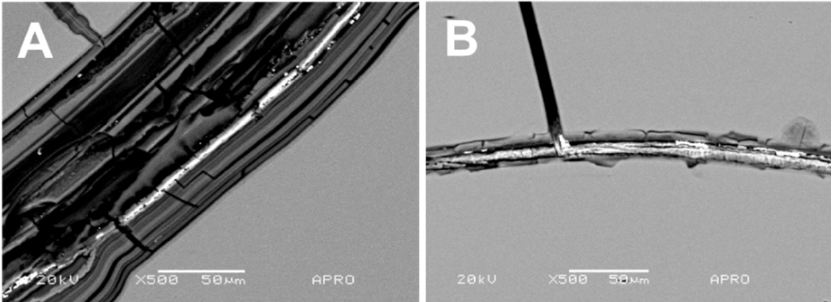
Figure 3. SEM images of silver foil glass beads from the tomb of King Muryeong in Korea. ( A ): Gold-colored (mr-13), ( B ): Silver-colored (mr-16).